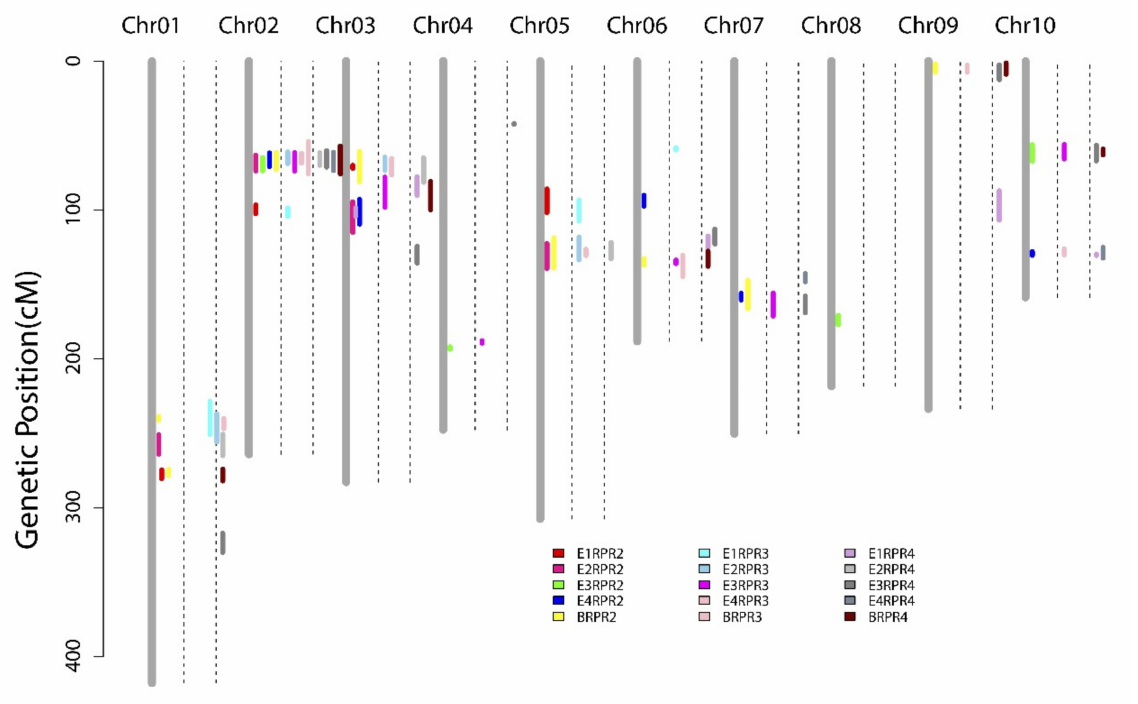
Figure 4. QTL mapping of rind penetrometer resistance across four environments and the BLUP model. Colored bars represent QTLs associated with different traits; E1, E2, E3, E4, and B represent the corresponding environment or BLUP model. The two dashed lines next to each chromosome separate the RPR-related QTL mapping results for different internodes, RPR2, RPR3, and RPR4, in order. The length of the colored bar indicates the 1.5-LOD QTL support